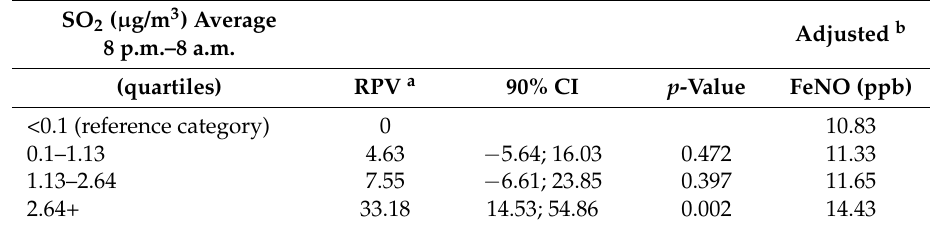
Table 8. Dose-response relation between SO 2 (average 8 p.m.-8 a.m.) and fractional exhaled nitric oxide (FeNO) in the Panel 20 study: relative percent variation (RPV) and adjusted FeNO. Sarroch (Sardinia), Italy (January–June